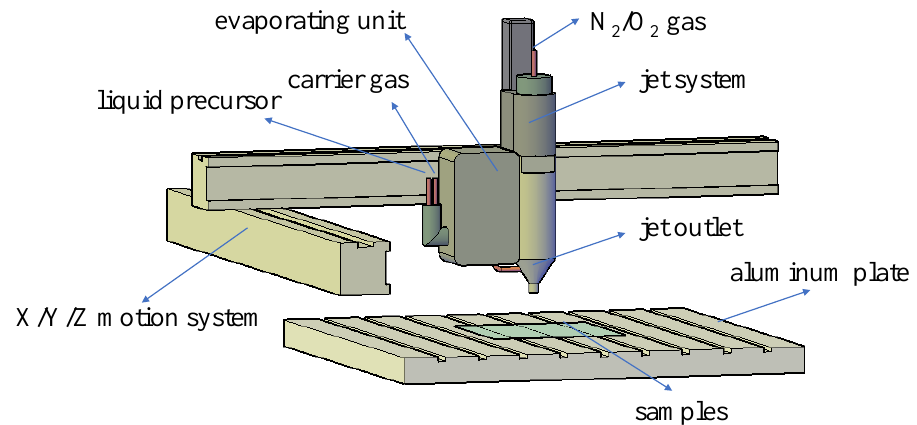
Figure 1. A schematic diagram of the atmospheric pressure glow discharge plasma system.